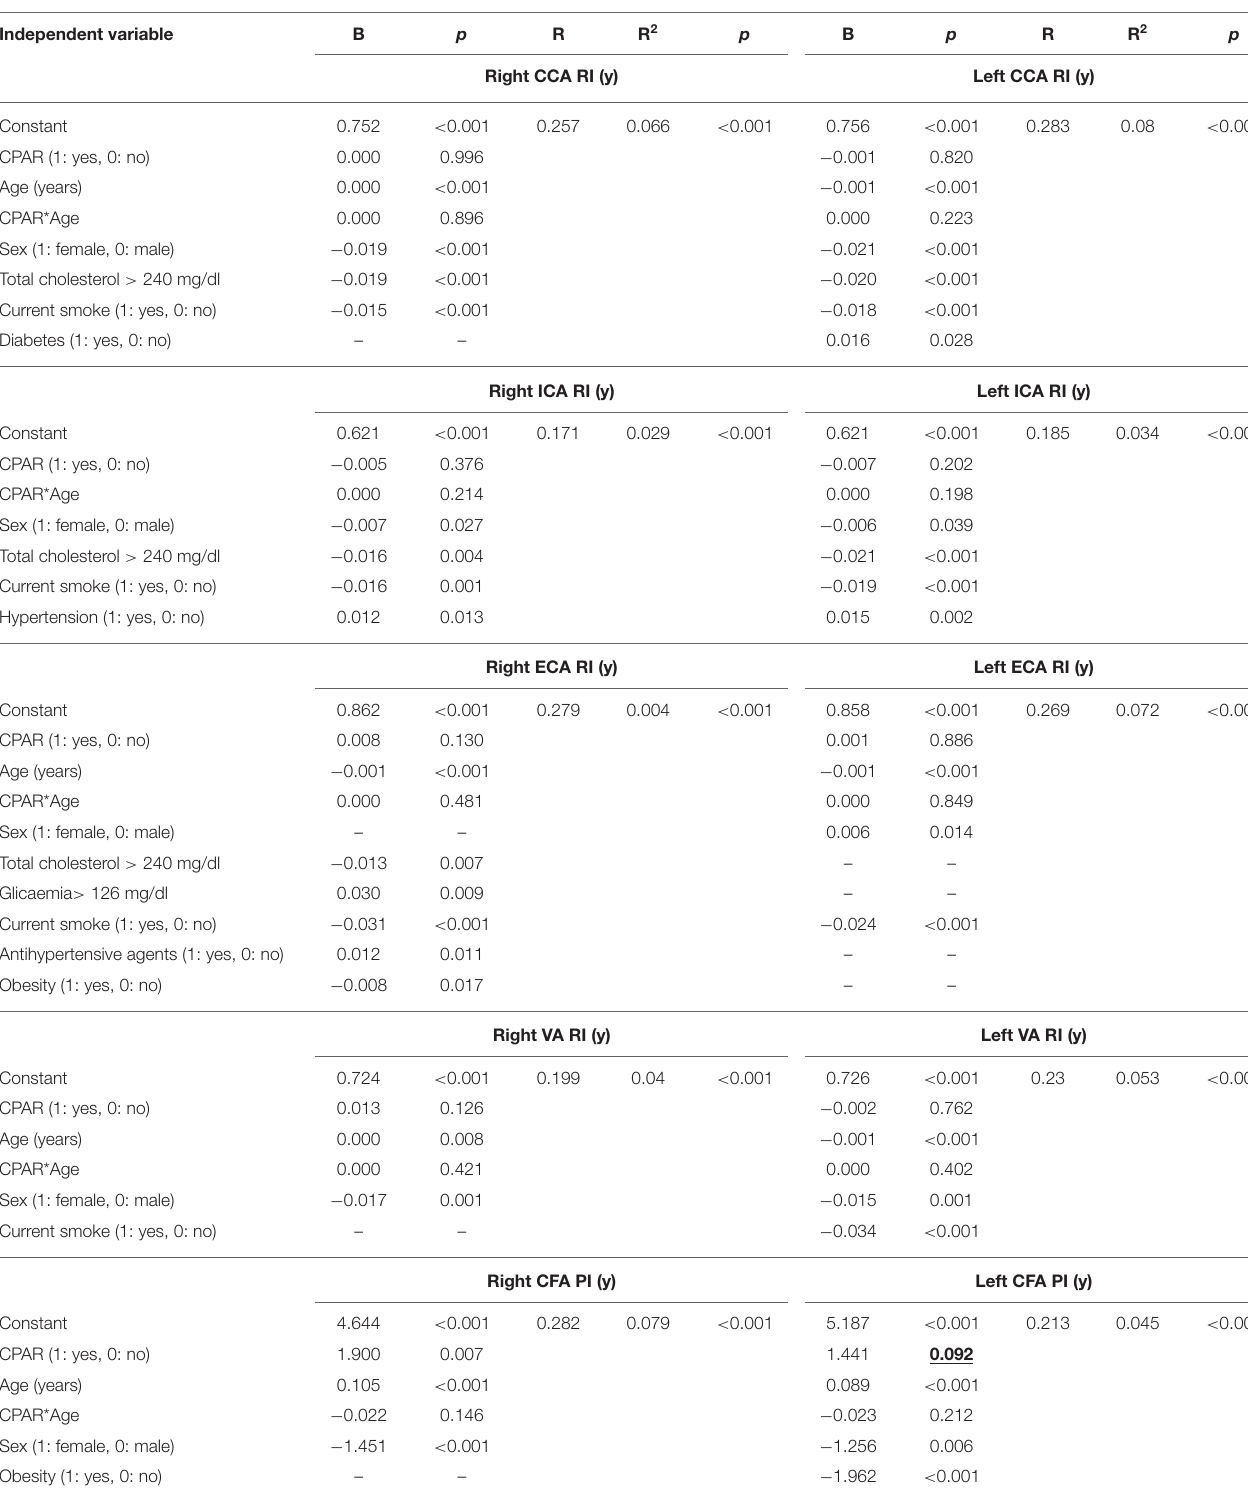
TABLE 11 | Association between CPARs and blood flow Doppler-derived indexes, with age as a moderating variable. Independent